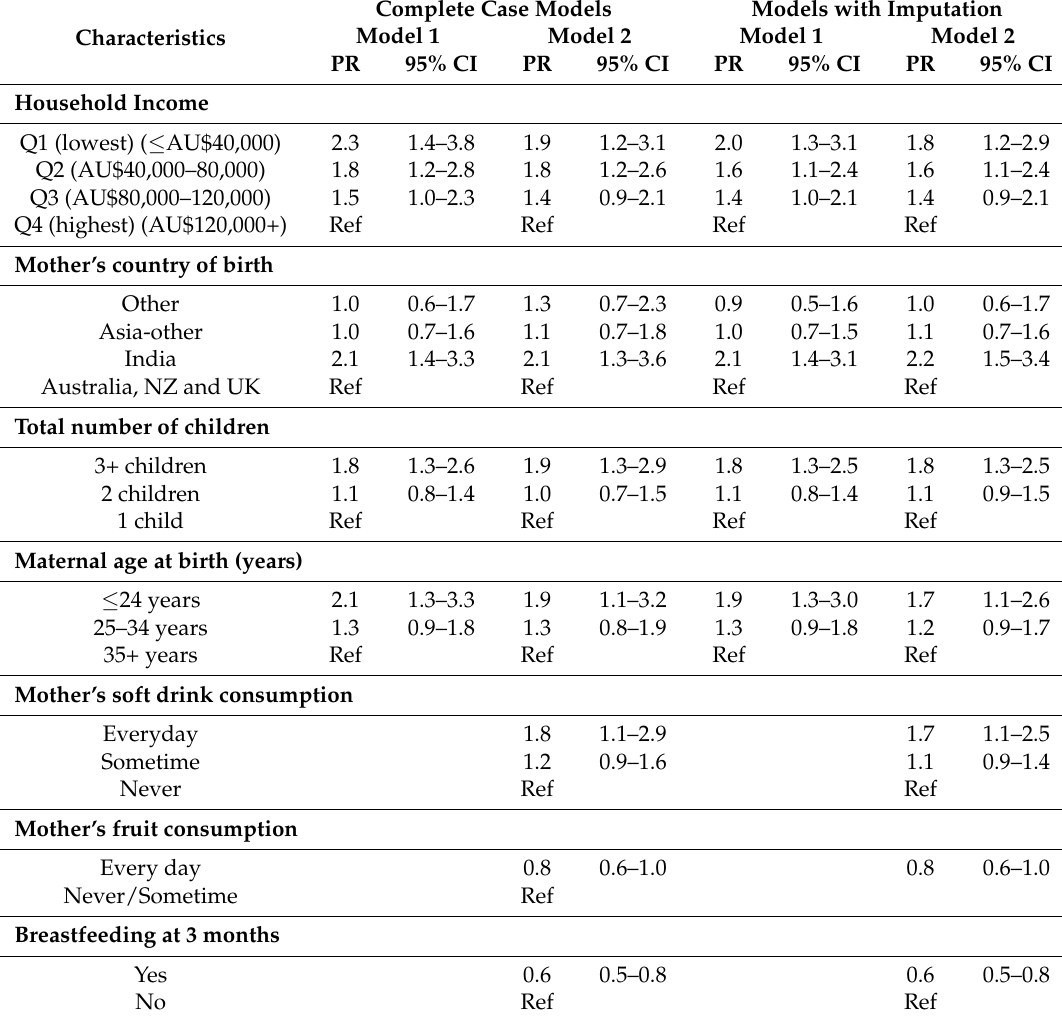
Table 3. Multivariable regression model for early introduction to foods or drinks with free